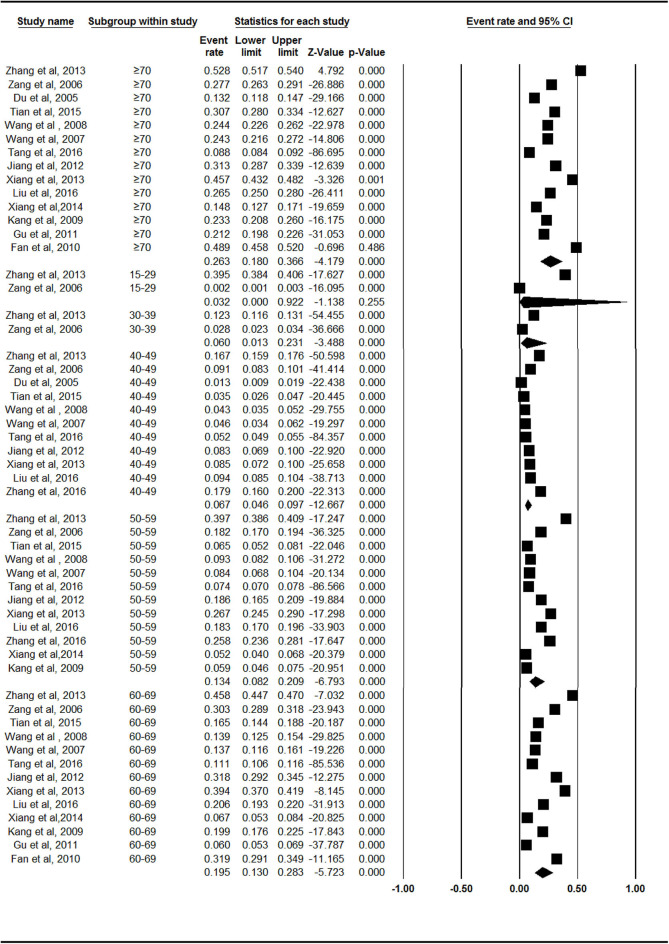
Forest plot of the prevalence rates of symptomatic knee osteoarthritis by age. CI, confidence interval. The prevalence of symptomatic knee osteoarthritis in different age group of 15–39 years old (n = 2), 40–49 years old (n = 11), 50–59 years old (n = 12), 60–69 years old (n = 13), over 70 years old (n = 14), respectively, were investigated. The prevalence rates of symptomatic knee osteoarthritis was evaluated as follows: 3.1% (95% CI = 0.7–13.0%) in 15–39 years old, 6.7% (95% CI = 4.6–9.7%) in 40–49 years old, 13.4% (95% CI = 8.2–20.9%) in 50–59 years old, 19.5% (95% CI = 13.0–28.3%) in 60–69 years old, 26.3% (95% CI = 18.0–36.6%) in age group over 70 years old.